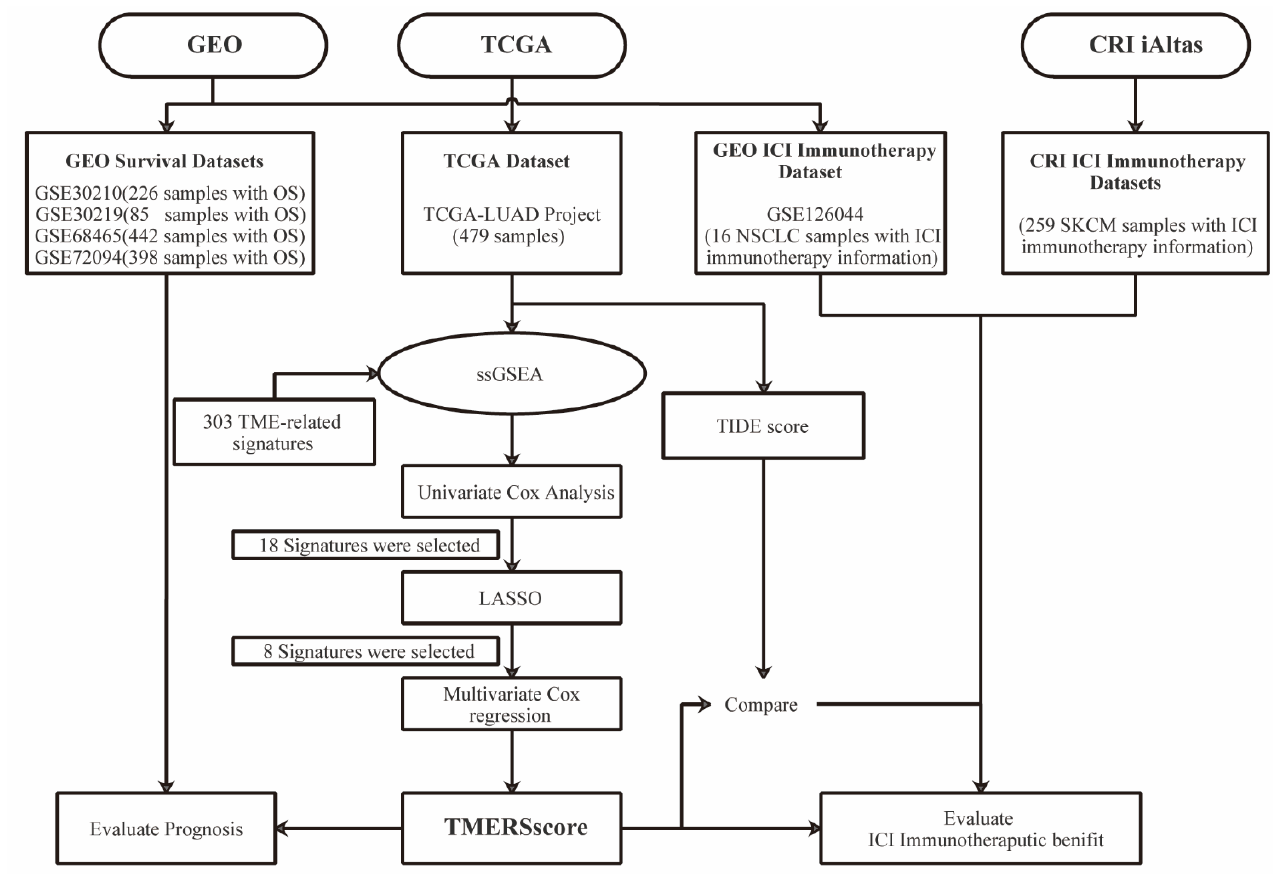
Figure 1. Flowchart of our research process.